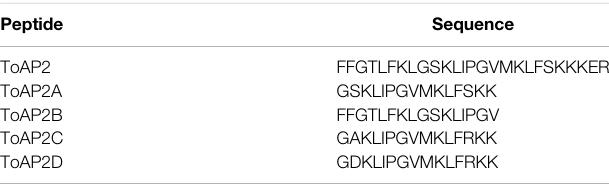
TABLE 1 | The comparison of ToAP2 amino acid sequences and derived peptides. Peptide Sequence